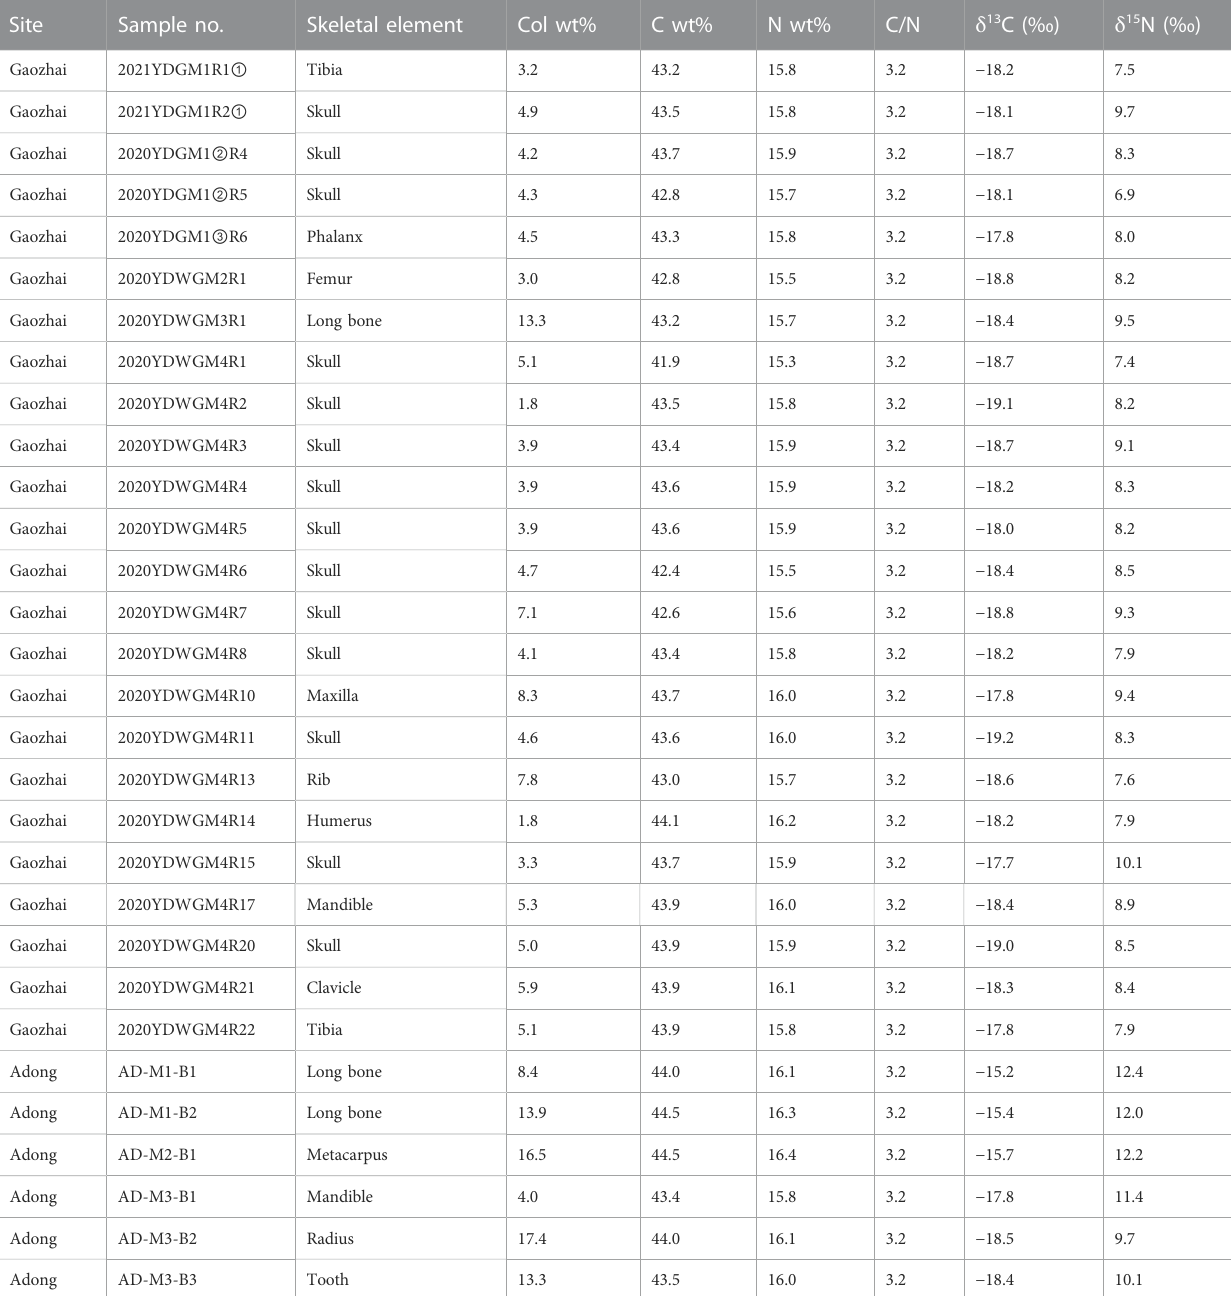
TABLE 1 The collagen isotopic results of human bones at the Gaozhai and Adong tombs. Site Sample